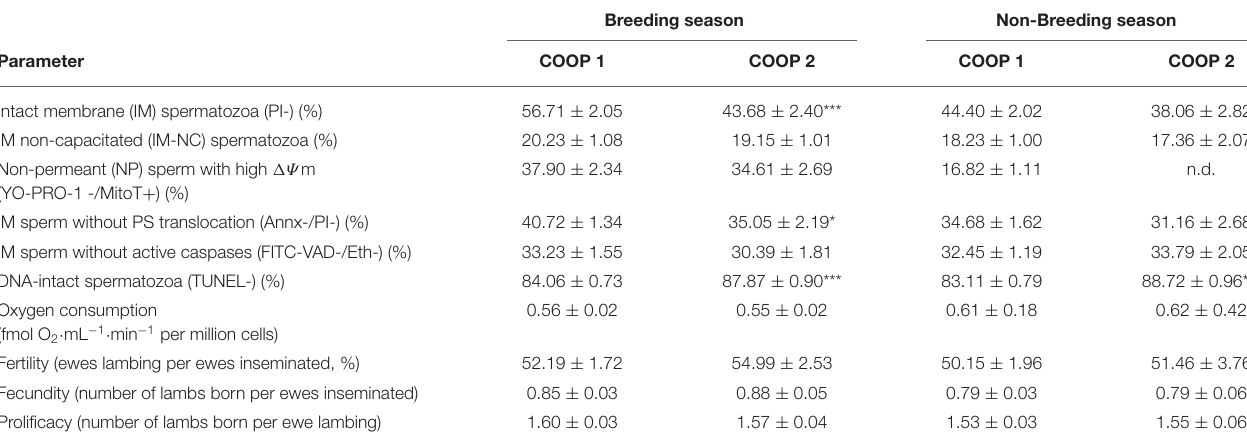
TABLE 4 | Differences in analyzed parameters between seminal doses from the breeding and the non-breeding season for both